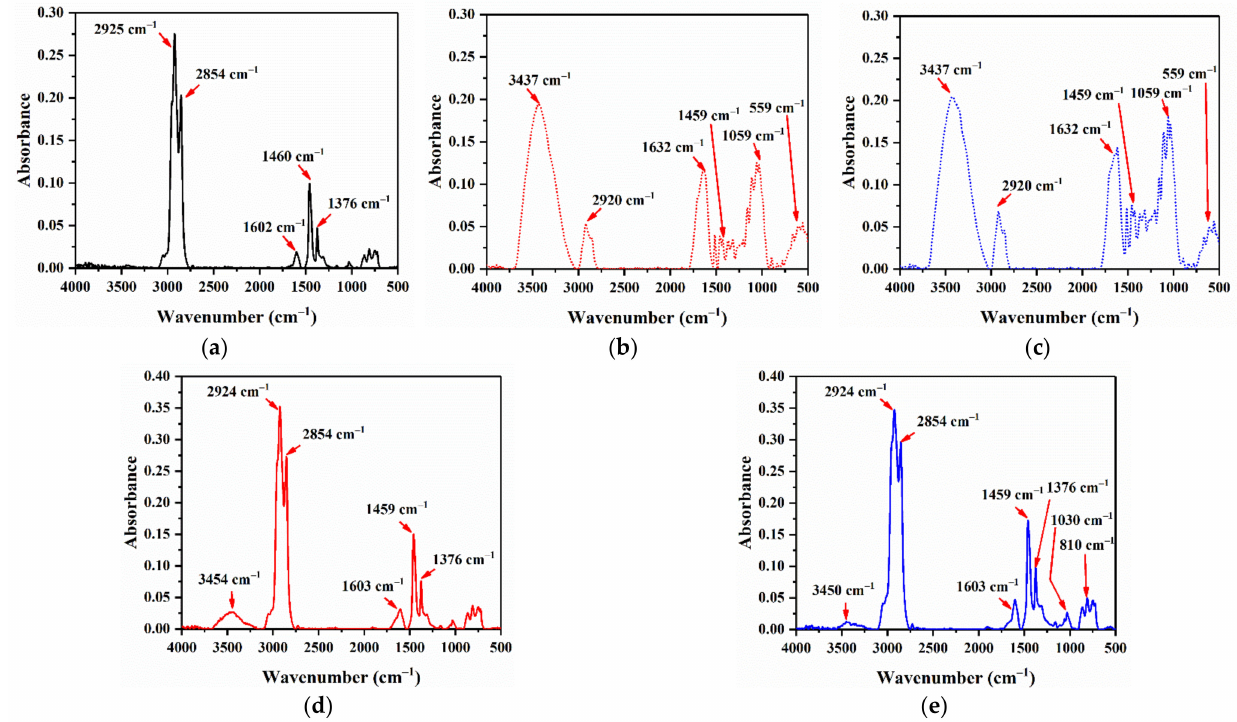
Figure 12. Fourier-transform infrared spectroscopy (FTIR) test results: ( a ) base asphalt; ( b ) HA; ( c ) HB; ( d ) HAMA; and ( e ) HBMA.